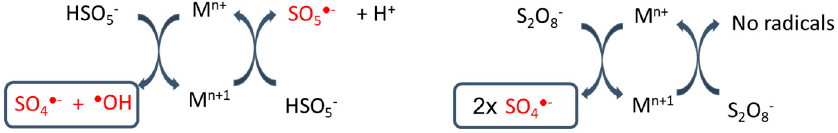
Figure 3. PMS and PS activation pathways in catalytic activation using transition metals.